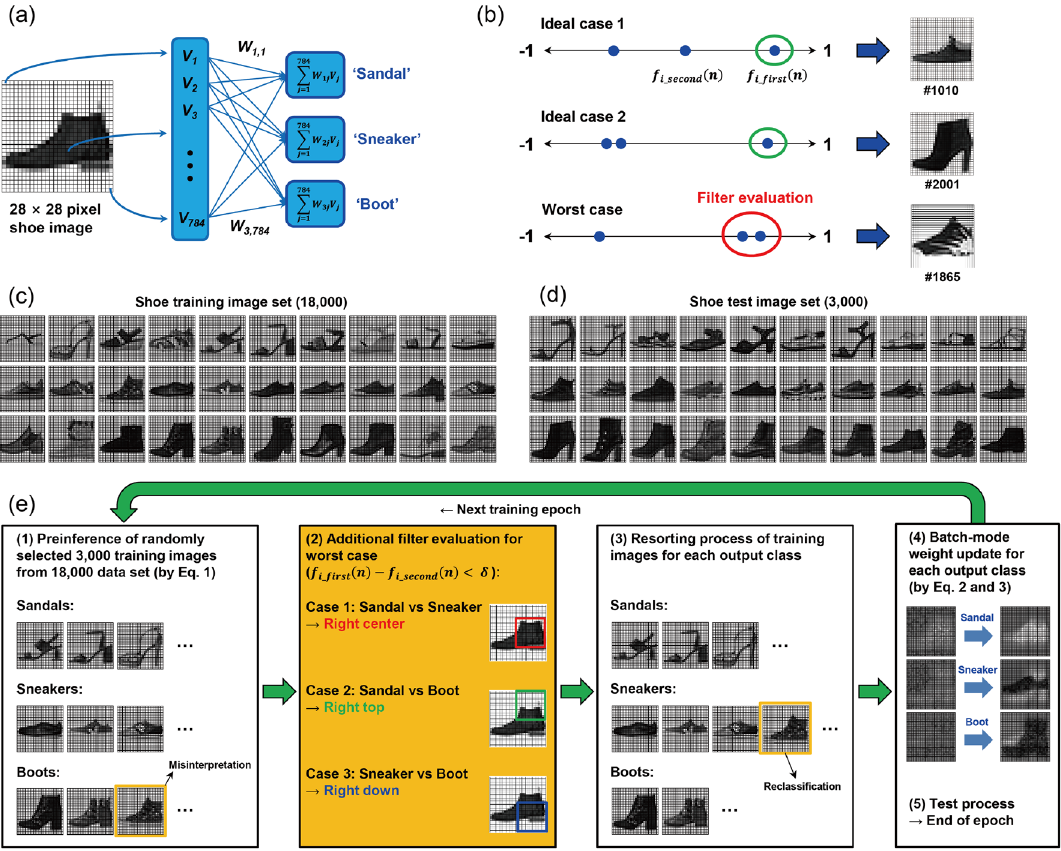
Figure 1. ( a ) Constituents of FCSN for the 28 × 28 shoe image inference process. Each input pixel is linked to the output neurons consisting of ‘Sandal’, ‘Sneaker’ and ‘Boot’ with a synaptic weight. ( b ) Configuration of the activation function showing 3 output results for each input image (between − 1 and 1) for the ideal cases (upper and middle line) and worst case (lower line). ( c ) 18,000 training images and ( d ) 3,000 test images for the shoe data set. ( e ) Flow chart of one epoch of the training/test algorithm, where the yellow box shows that the filter evaluation is only executed if the difference between the first and second activation function values is smaller than the predetermined